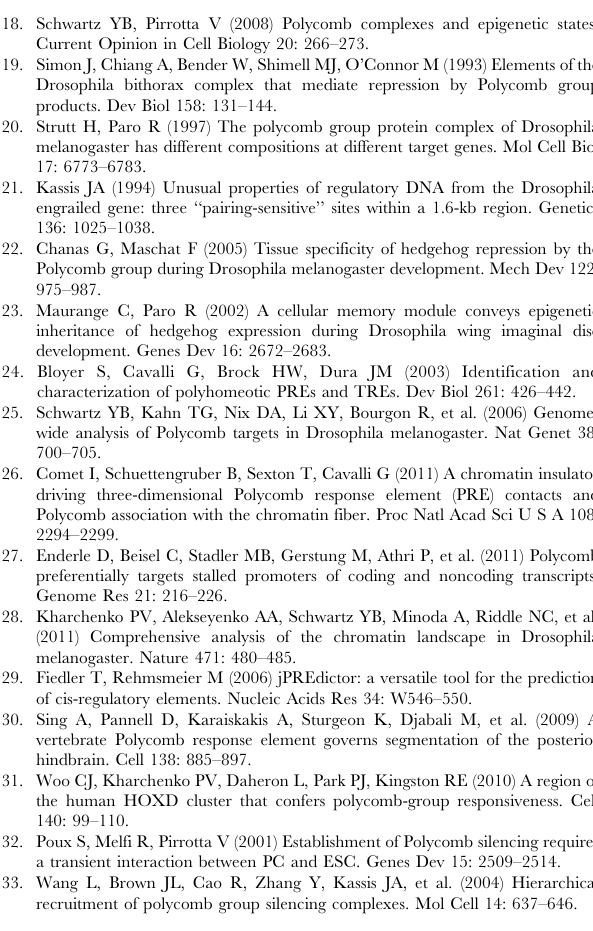
embryonic brain (top) compared to pluripotent cells derived from a del(10) embryo (iPS, bottom). (TIF) Figure S5 H3K27me3 and RNA profiles in various cell lines. ChIP-qPCR and mRNA expression of control and Hoxd genes in various constructs eletroporated in iPS cells carrying a deletion of Hoxd10 . Lnp is located outside the HoxD cluster and is used as a control for active genes, while Hoxd13 is used as a control for silent genes. Clones and culture conditions are color coded and specified on the top. G418 stands for the presence ( + ) or absence ( 2 ) of the antibiotic. Vector refers to a control cell line. (TIF) Table S1 List of the primers used for RT-PCR, either for ChIP experiments (top) or for RNA dosage